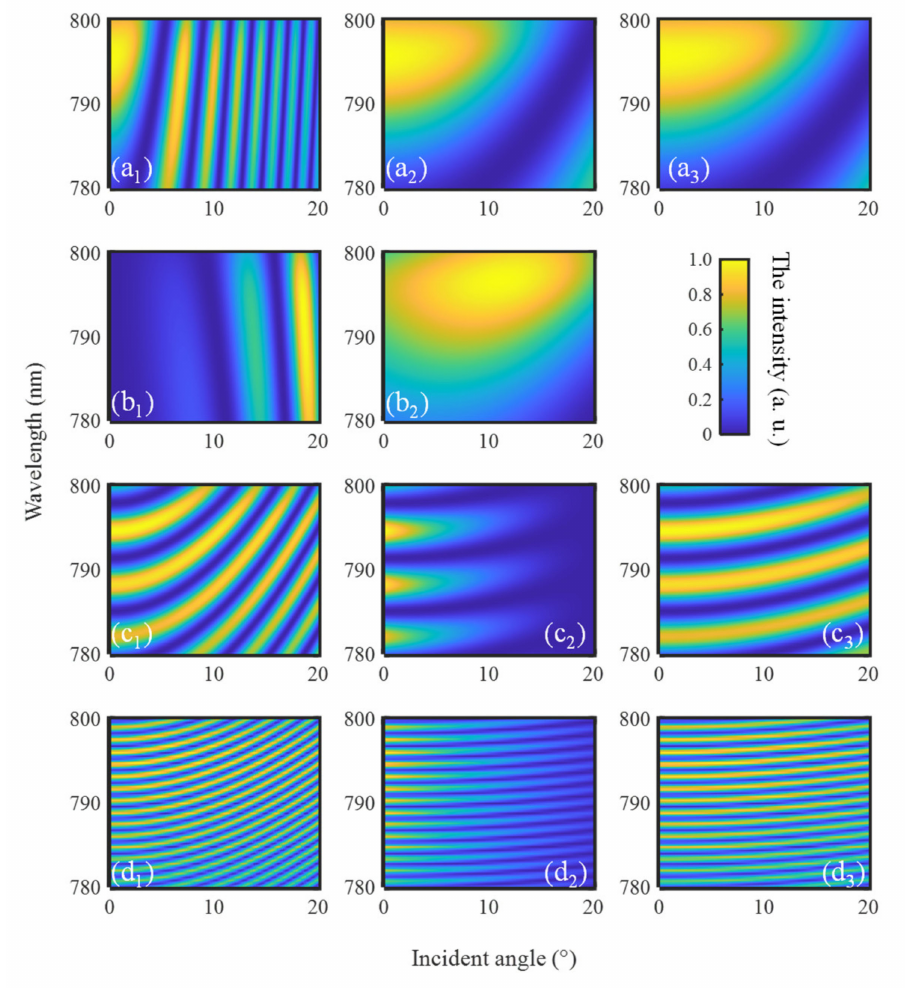
Figure 10. The calculation results of peaks shift in the optical frequency domain. The figures ( a – d ) denote the nonlinear materials BBO, KDP, LiNbO 3 , and Ag 3 AsS 3 in order, the subscript numbers 1, 2, 3 denote the polarization combinations p-s, p-p, and s-s,